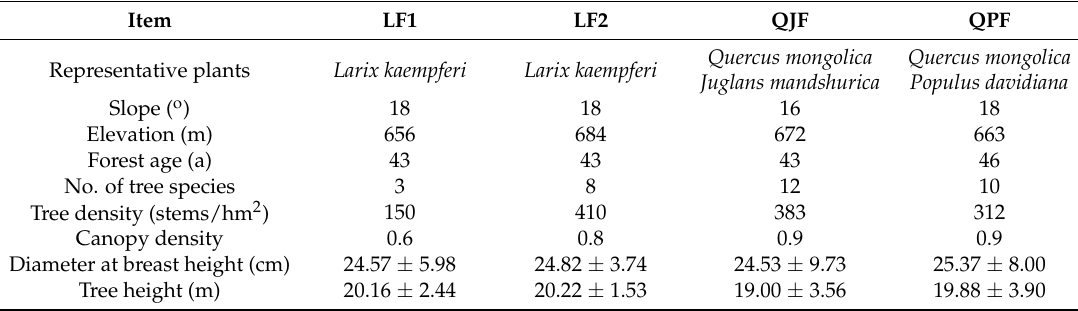
Table 1. Main characteristics of LF1, LF2, QJF and QPF Table 1 . Main characteristics of LF1, LF2, QJF and QPF stands.